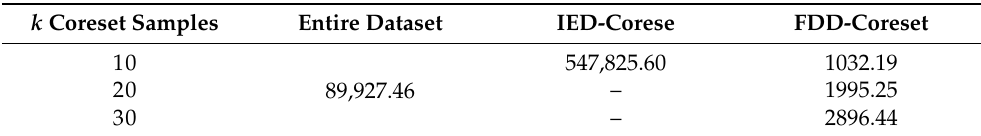
Table 2. Computation time comparison of BlobGAN trained on entire dataset (1000 random sam- ples), IED-Coreset ( k = 10) and proposed FDD-Coreset ( k = 10, 20, 30) on 3D synthetic blob images (unit: